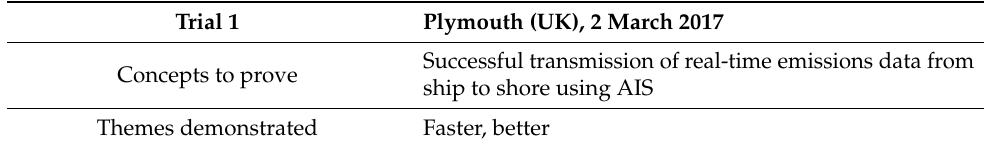
Figure 1. Schematic of the emissions reporting system as setup on the RV Plymouth Quest for Trial 1. Table 1. Concepts proved and themes demonstrated on Trial